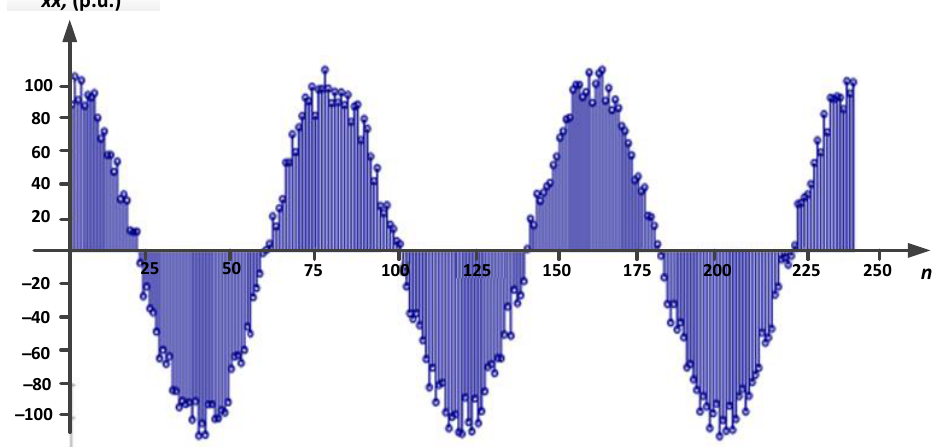
Figure 3. Oscillogram of a sinusoidal current (voltage) signal distorted by noise.